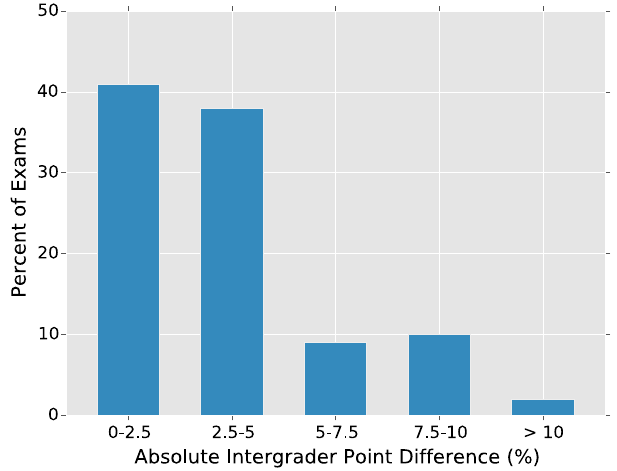
FIG. 3. The absolute difference in CCMI scores assigned by a trained and untrained grader is presented. The average difference on total CCMI score between the trained and untrained grader is 3.5% (cid:3) 2 . 7% . The graders agreed to 5% on overall score for 79% of the